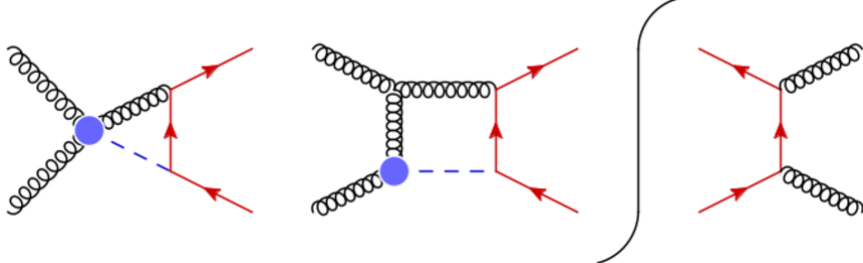
Figure 2 . Non-factorisable corrections (selected) to the interference at NLO.